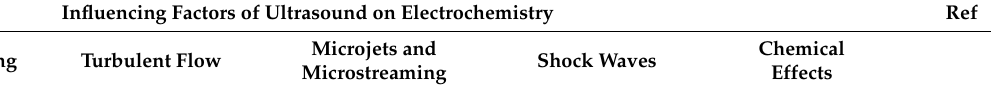
Table 1. Summary of major influencing factors of ultrasound on electrochemical